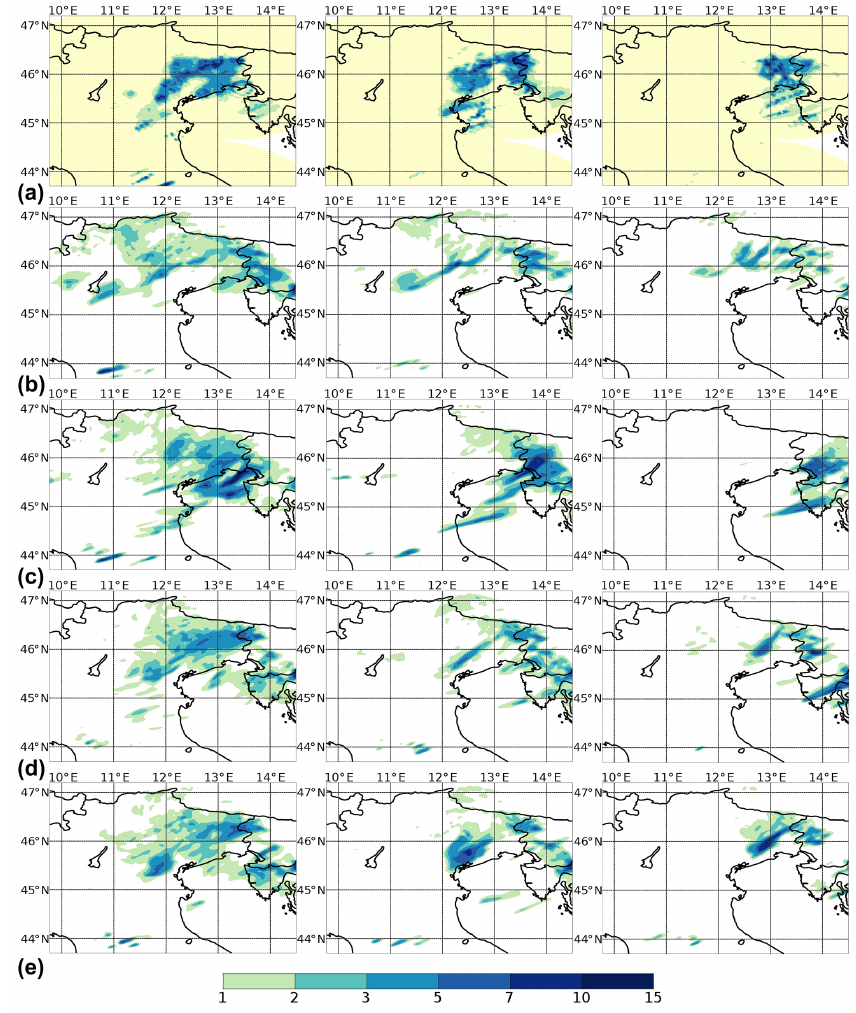
Figure 4. In panel (a) , the observed field, consisting of hourly rainfall estimated from radars corrected by rain gauges, is shown for 8 February at 13:00, 14:00 and 15:00UTC; the shaded yellow area highlights the acquisition domain of the Italian radar network. In the subsequent rows, forecast hourly precipitation of experiments conv60_nolhn (b) , conv60 (c) , rad60_nolhn (d) and rad60 (e) initialized on 3 February at 12:00UTC is shown. Each column represents different lead times, from + 1 to + 3h going from left to